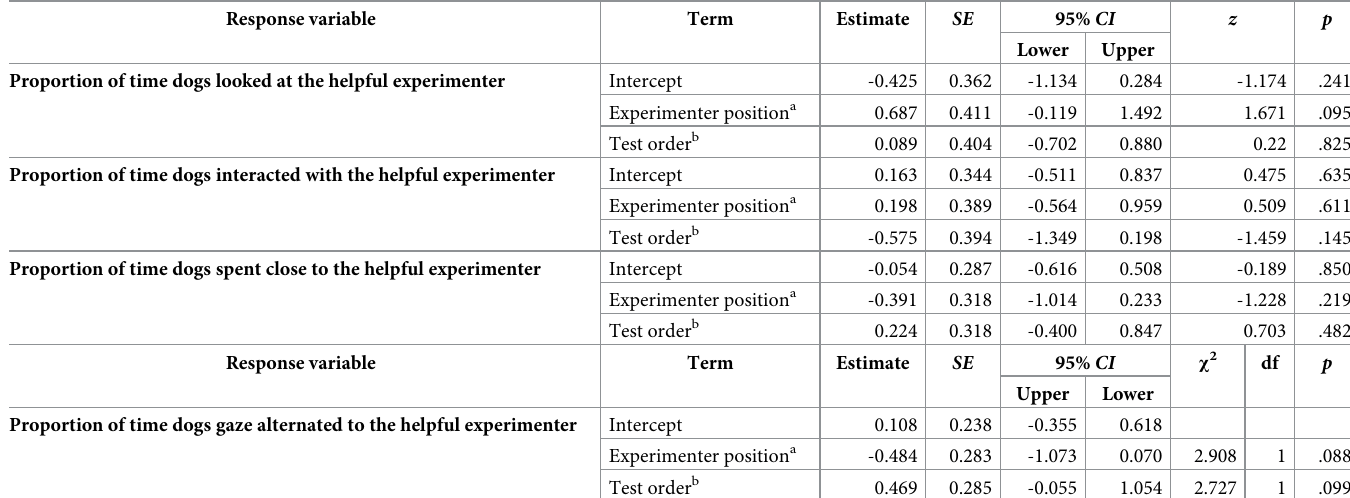
Table 3. Results of reduced models (lacking the interaction) in the impossible